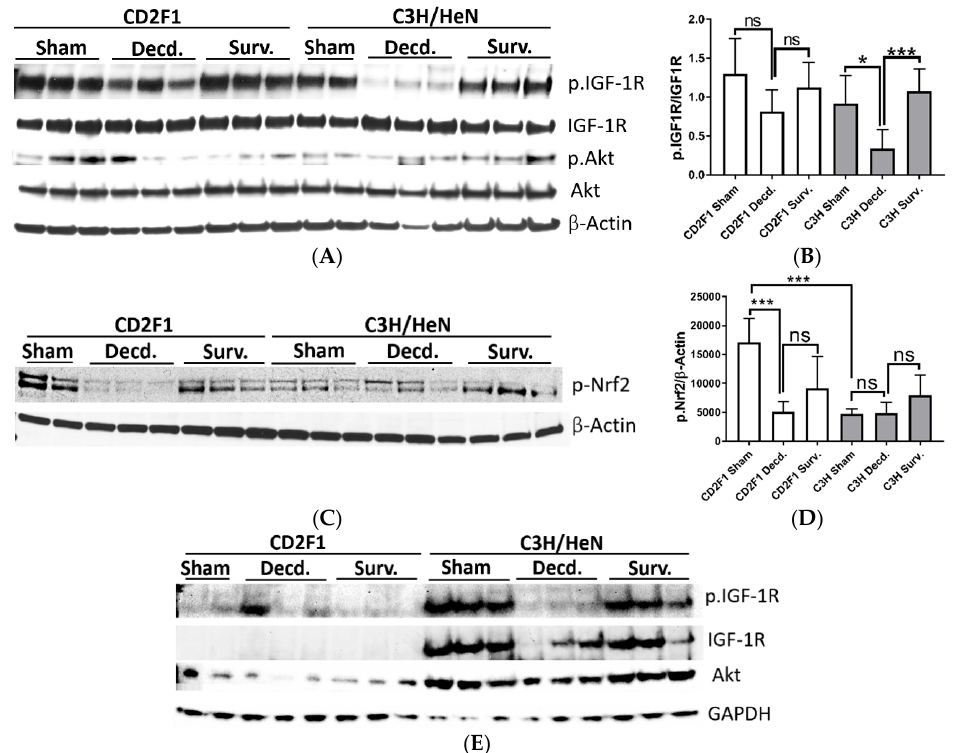
Figure 6. Western blot analysis of IGF-1R, Akt and Nrf2 in lung and kidney samples from sham and LD 70/30 irradiated CD2F1 and C3H/HeN adult male mice. ( A ) Analysis of phosphorylated IGF-1 receptor (p.IGF1R, Tyr1135/1136), total IGF-1R, phosphorylated Akt (p.Akt, Ser473), total Akt and ( C ) phosphorylated Nrf2 (p.Nrf2, Ser40) in lung protein extracts from sham, irradiated decedent (Decd.) and irradiated survivor (Surv.) mice. β –Actin used as loading control. ( B , D ) Quantification of IGF-1R and Nrf2 activation in the lung samples. IGF-1R activation is determined by calculating the ratio of the pixel intensity of p.IGF-1R to total IGF-1R levels. Nrf2 activation is determined by calculating the ratio of pixel intensity of the p.Nrf2 to respective β –Actin band. ( E ) Western blot analysis of phosphorylated IGF-1 receptor (p.IGF1R, Tyr1135/1136), total IGF-1R and total Akt in kidney protein extracts from sham, irradiated decedent (Decd.) and irradiated survivor (Surv.) mice. GAPDH is used as loading control. Total number of analyzed samples for both strains: n = 6 for sham, n = 6 for decedents, n = 3 for survivors. Results analyzed by Student’s t -test; presented as mean ± SEM, * p < 0.05, *** p < 0.001 and p > 0.05 is considered as ‘not significant’